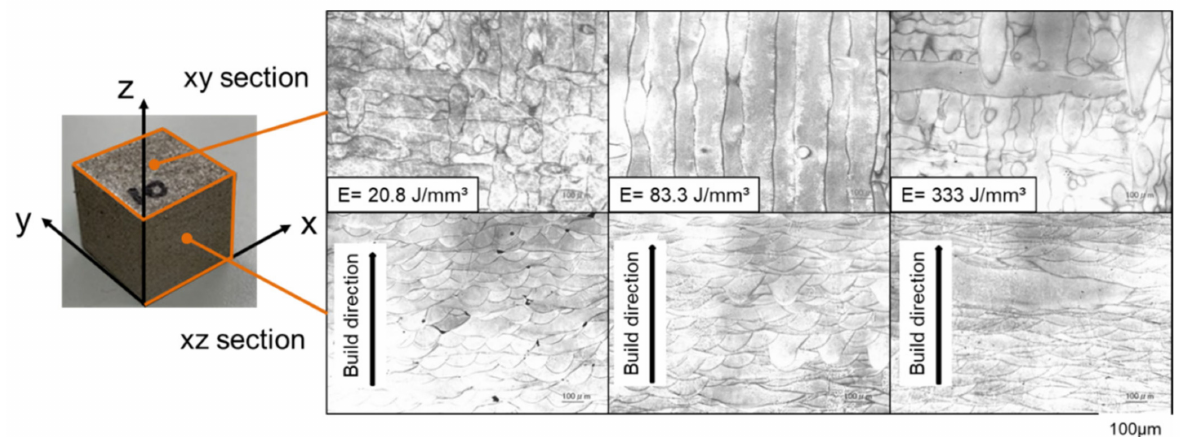
Figure 8. OM images of horizontal (xy) section and vertical (xz) section to the base plate of the as-built cubic specimens fabricated at various energy